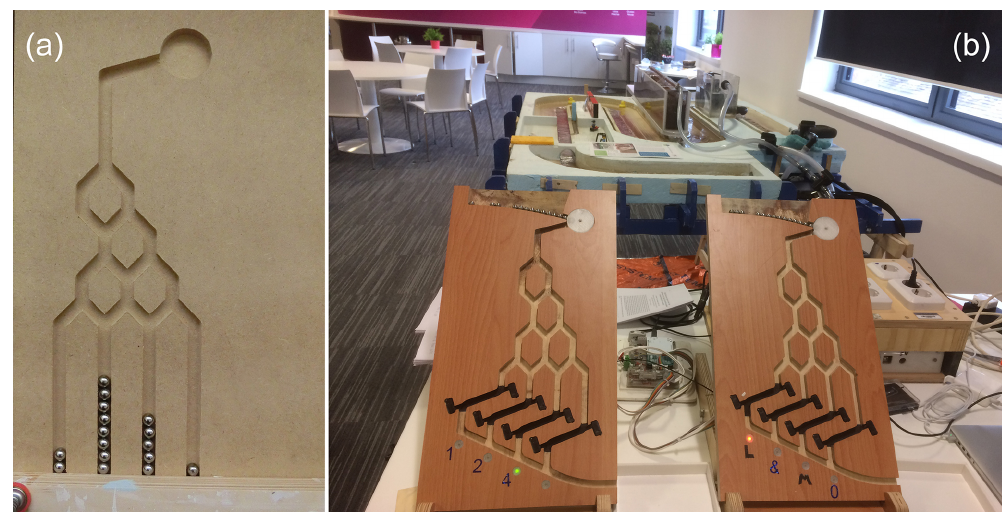
Figure 1. Photographs of asymmetric Galton boards. (a) Test board and (b) a final set-up. At every split the chance of a steel ball falling to the left or right is 50% for a well-balanced Galton board. When a sufficiently large number of steel balls falls through this Galton board, the discrete distribution becomes (3, 7, 5,1 )/ 16. The 4 × 4 possible outcomes in two of such boards, registered in each by four electronic eyes (located in the black-painted areas along 2 × 4 = 8 channels marked here by “1, 2, 4,...” and “ L , &, M , 0”), determine both the rainfall amount and its location(s) in Wetropolis. The outcome of the random draw, shown by the lit-up lights, will in this instance lead to 4s of rain in the lake/reservoir. Photos: Onno Bokhove and Wout